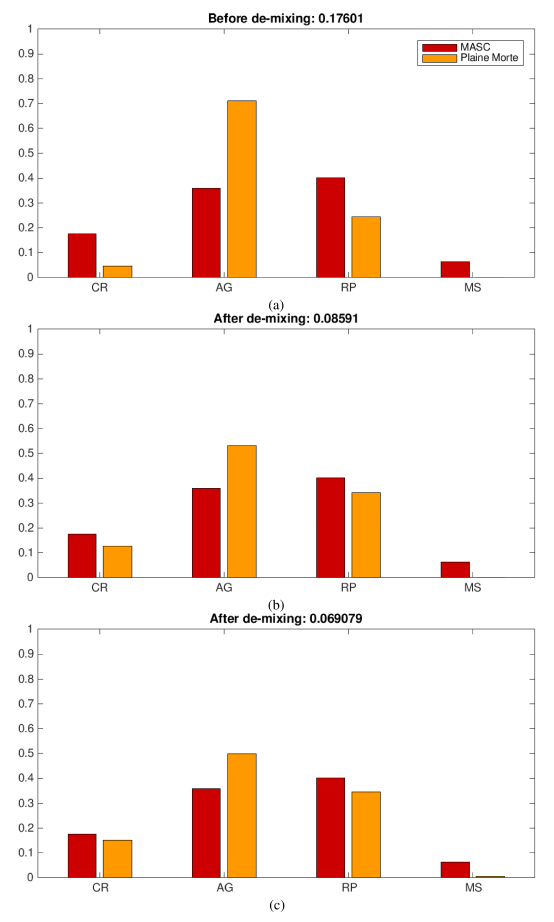
Figure 14. Comparison of classification applied to Plaine Morte data with the MASC classification, before de-mixing (a) and after de-mixing: with only three de-mixing components (b) and with all de-mixing components (c) .